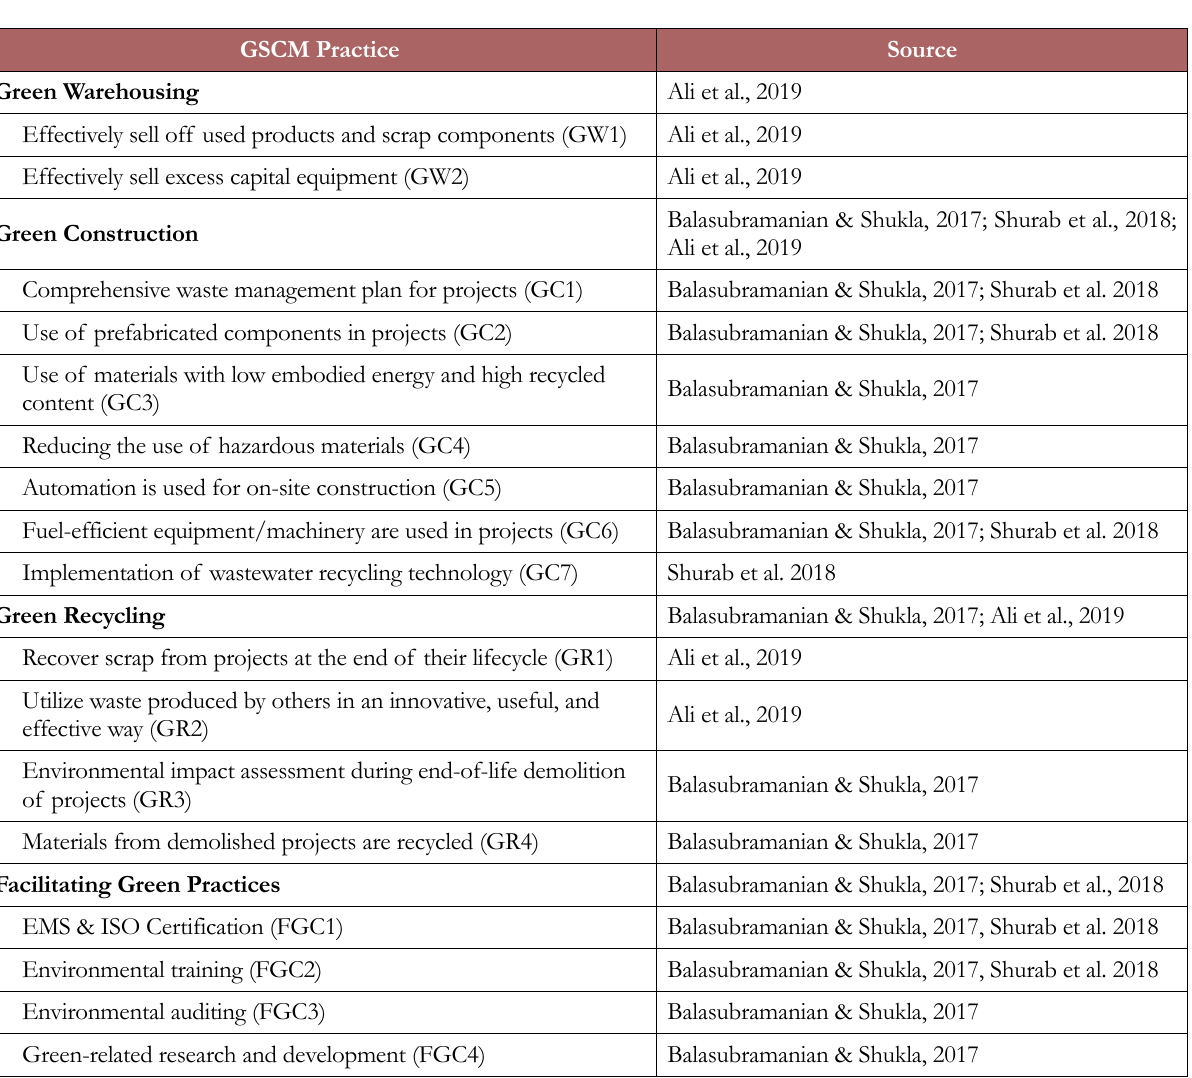
Table 1. Previous studies on GSCM